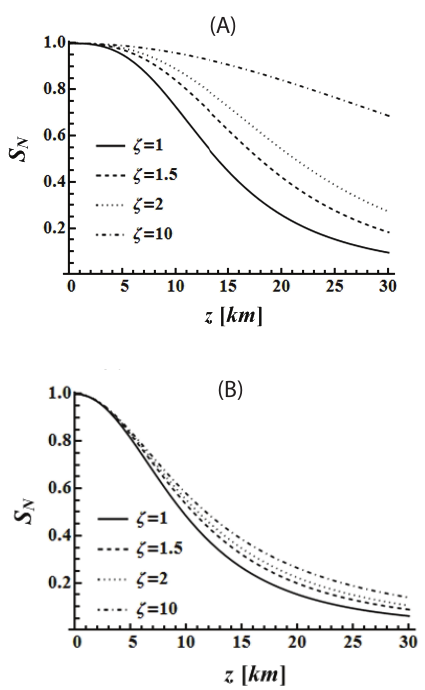
Figure 15. Spectral density S of ( A ) a coherent; ( B ) a partially coherent electromagnetic Gaussian– Schell model (EM GSM) beam in the up-link anisotropic turbulence, for α = 3.5 and several values of the effective anisotropic factor ξ ∼ µ − 1 z . Reprinted with permission from Reference